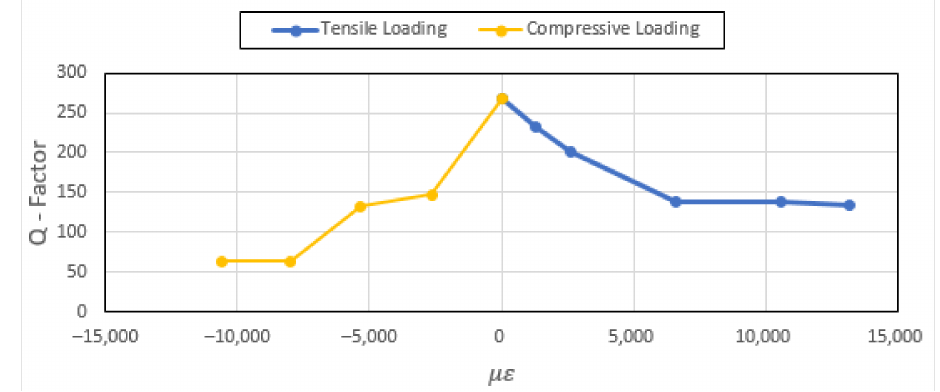
Figure 11. Effects of tensile and compressive loading on the patch antenna’s Q